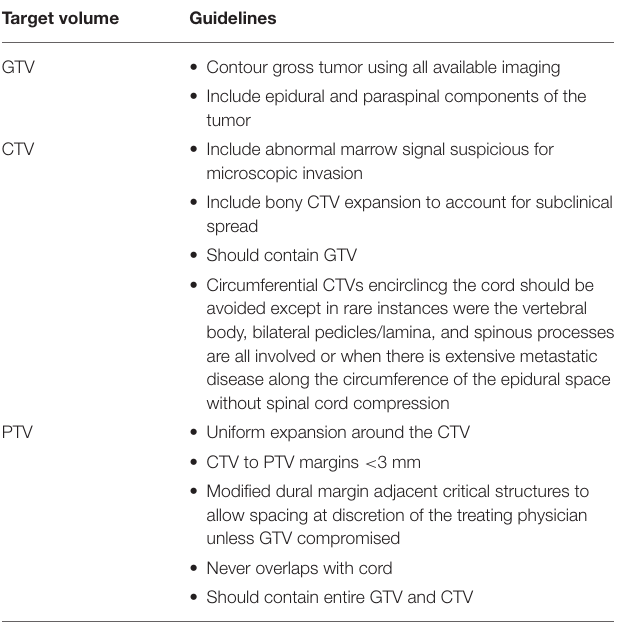
TABLE 5 | Summary of contouring guidelines for GTV, CTV, and PTV in spinal stereotactic